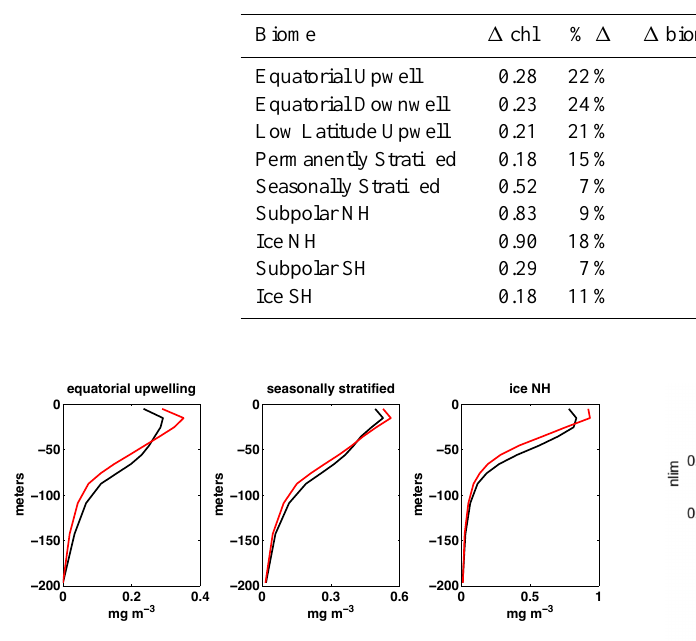
Figure 13. The depth profile of chlorophyll concentration mgm − 3 in three biomes. The black line indicates the chl-only run, red line represents chl&CDM run. The equatorial upwelling and seasonally stratified biomes show increased peaks in the deep chlorophyll max- imum (DCM) when CDM is included. All three biomes show in- creased chlorophyll near the surface, but diminished chlorophyll at depth.